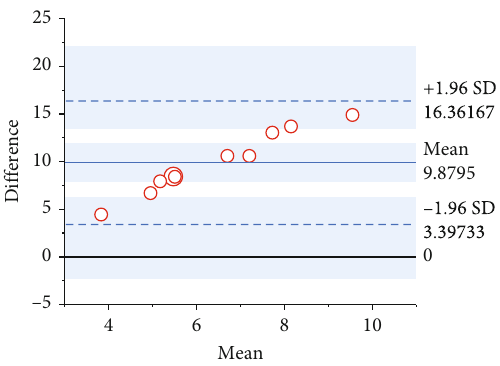
Figure 8: Construction of the fl ipped classroom knowledge